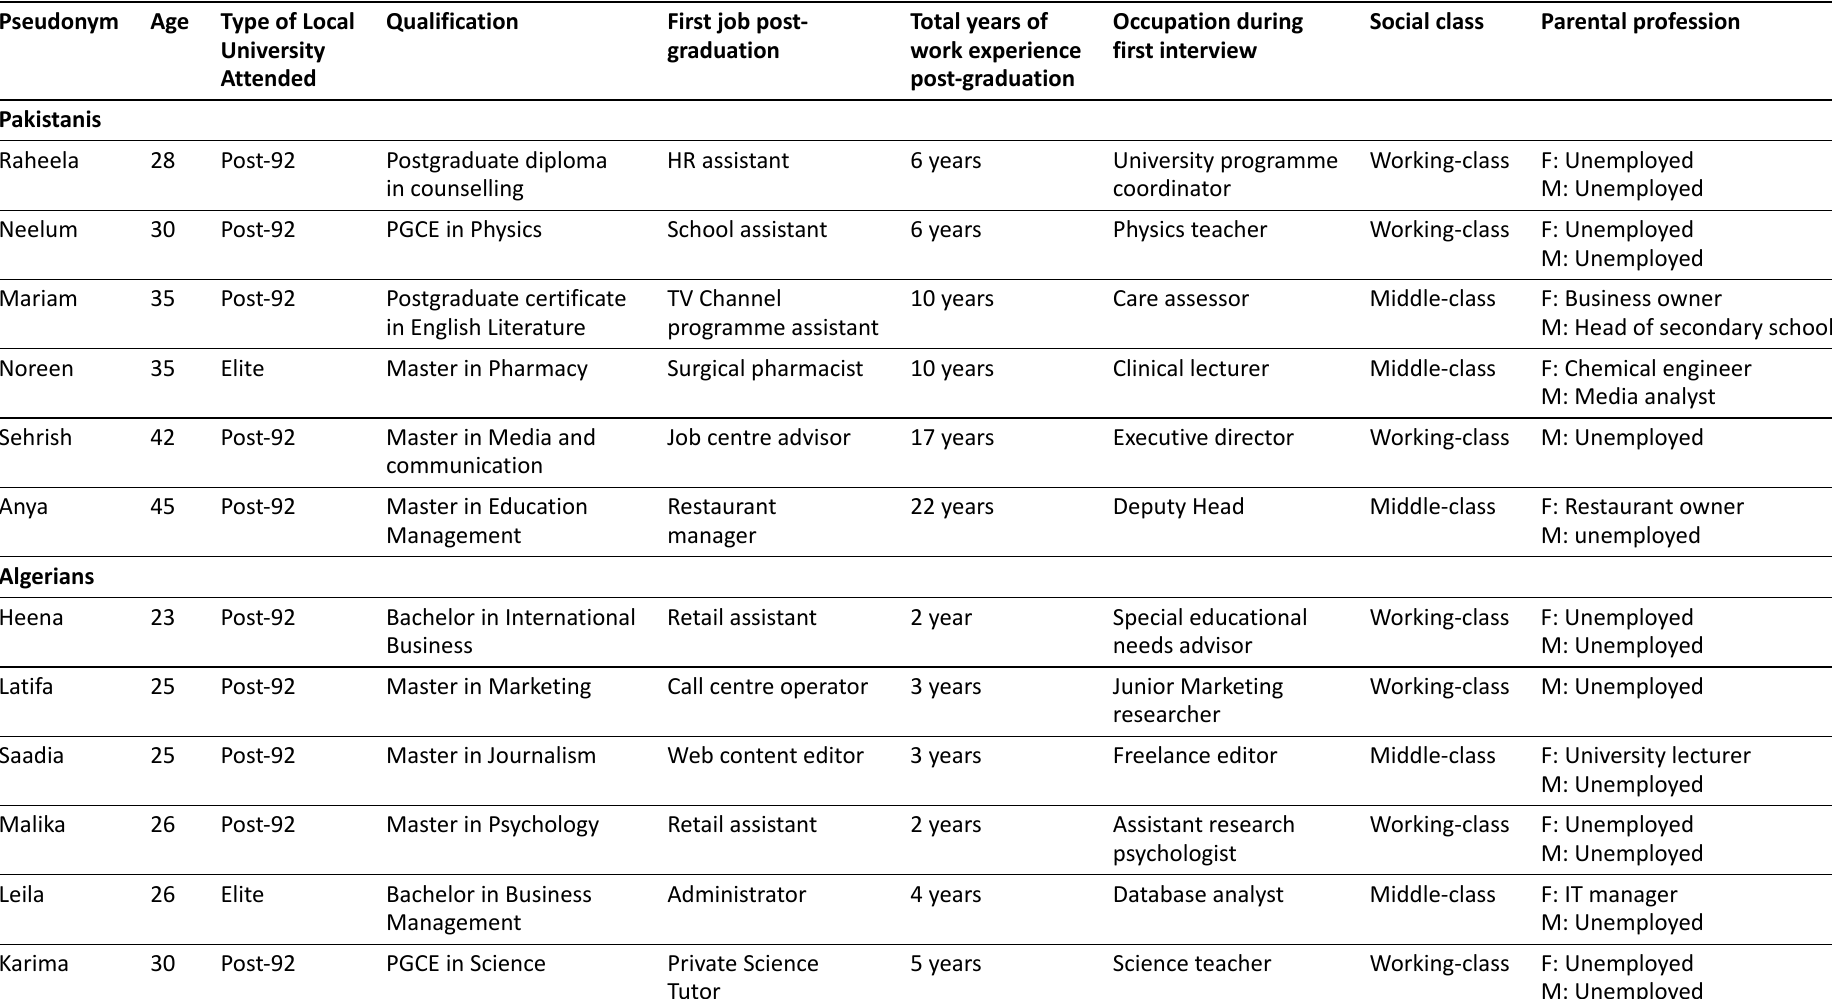
Table 1. Key socio-economic characteristics of British Pakistani and Algerian